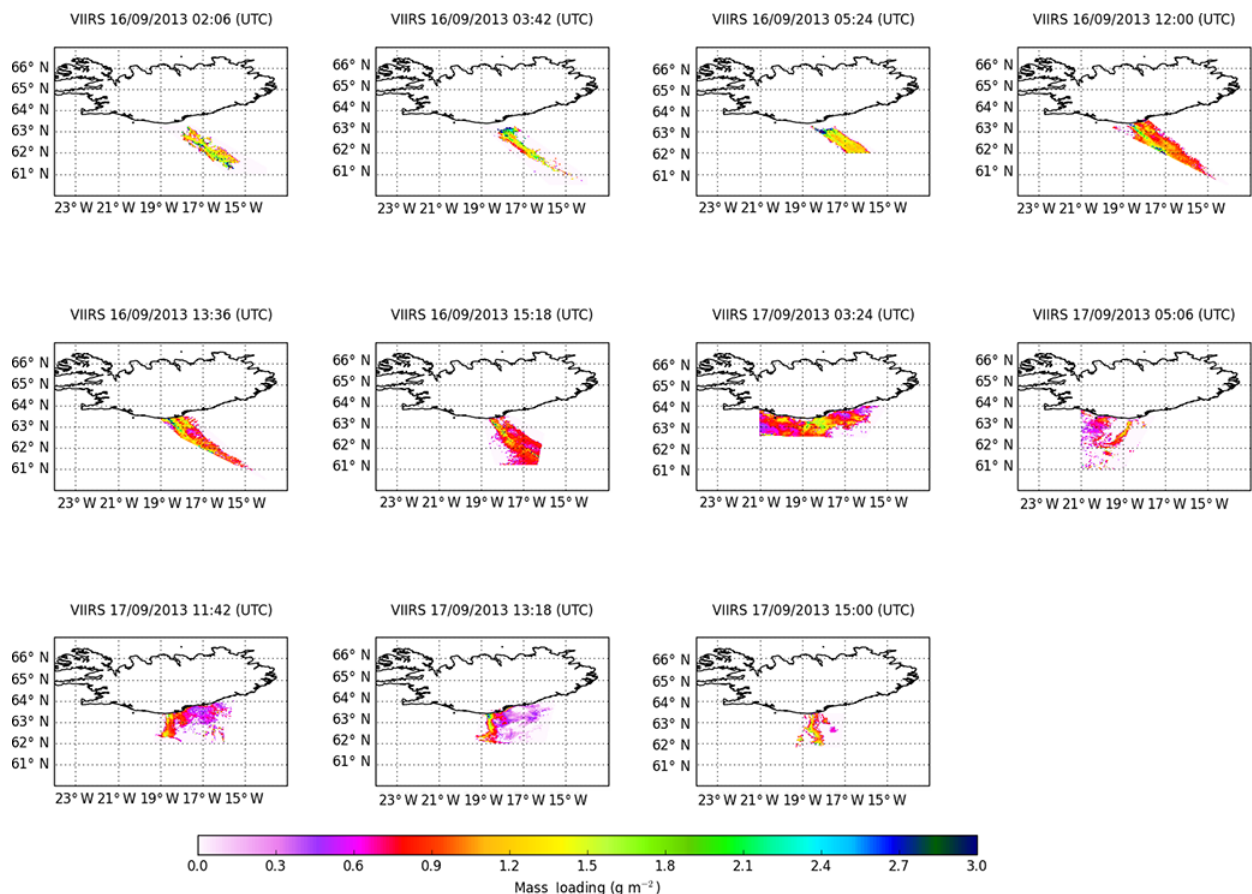
Figure 10. The resuspended ash mass loading retrieved from VIIRS infrared bands M15 and M16 for the areas identifed as containing ash.